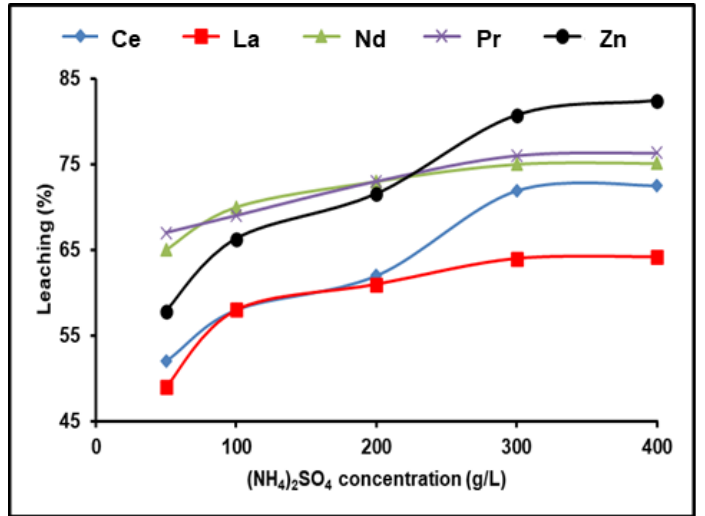
Figure 2. Influence of ammonium sulfate concentration on the dissolution of REEs and Zn from spent Ni ‒ MH battery powder (T: 90 °C, t: 120 min, 1:2 (S/L) ratio). Ni–MH battery powder (T: 90 ◦ C, t: 120 min, 1:2 (S/L) ratio).